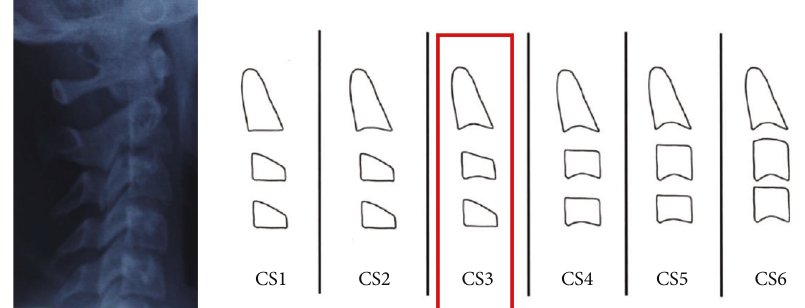
Figure 8: Vertebral stadiation.